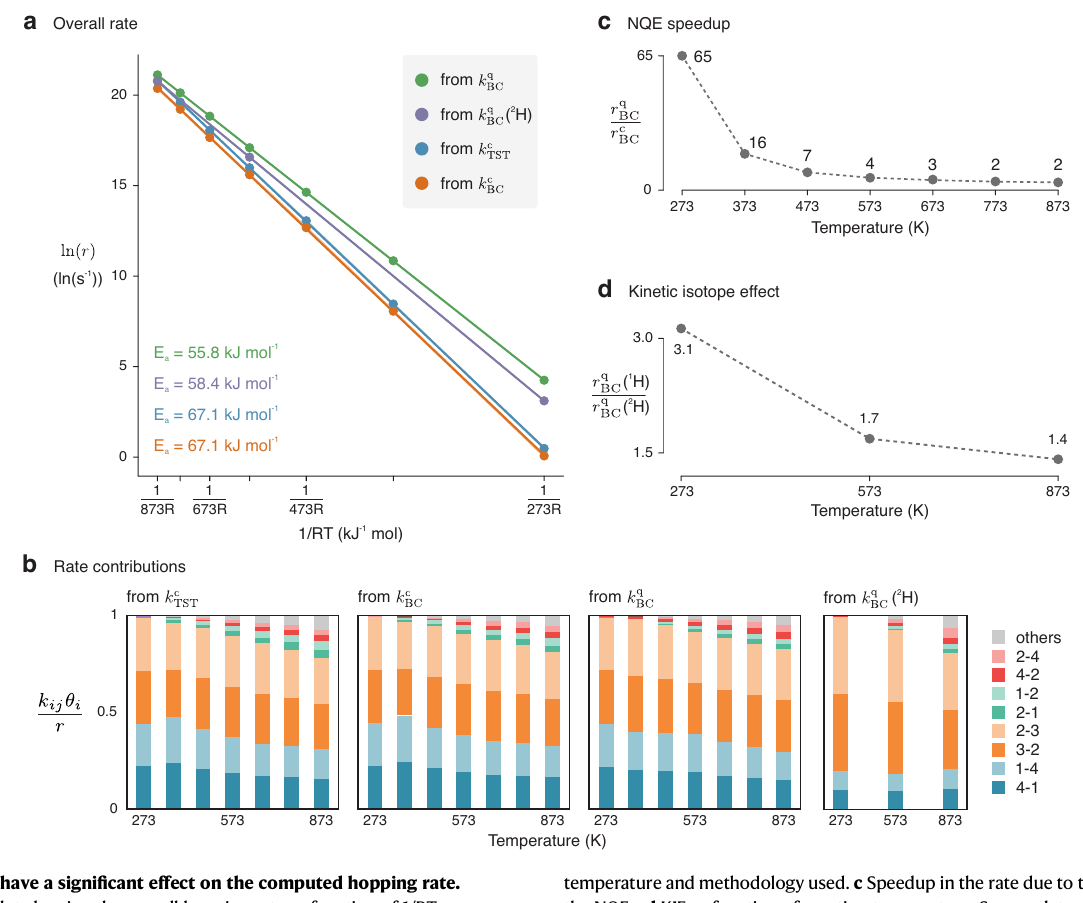
temperatureand methodology used. c Speedup in the rate due to the inclusion of the NQEs. d KIE as function of reaction temperature. Source data are provided as Source Data